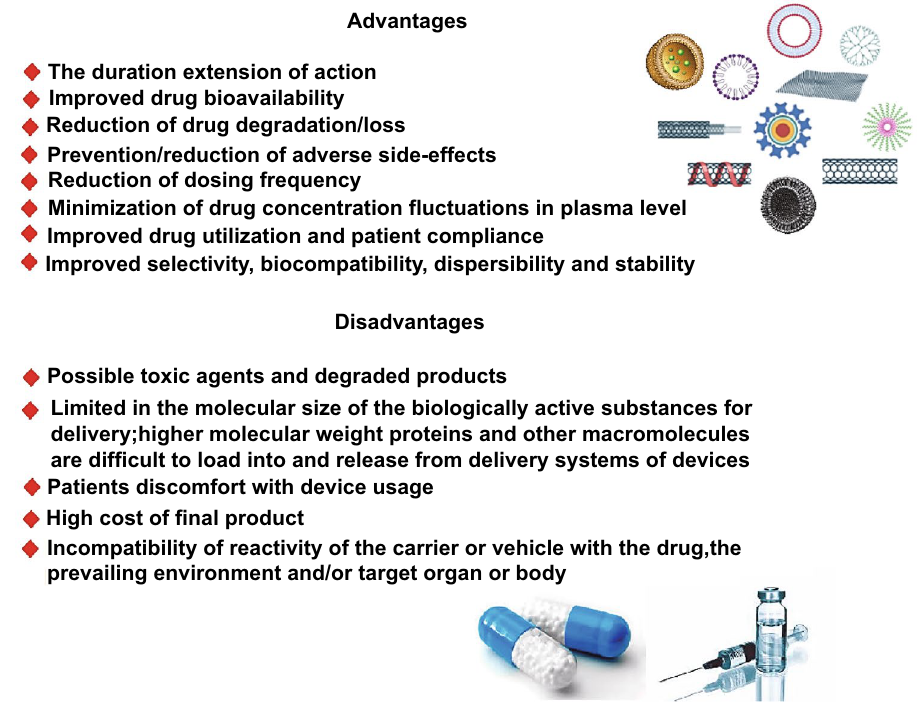
Fig. 1 Targeted drug delivery systems/carriers: important advantages and demerits. (Color figure